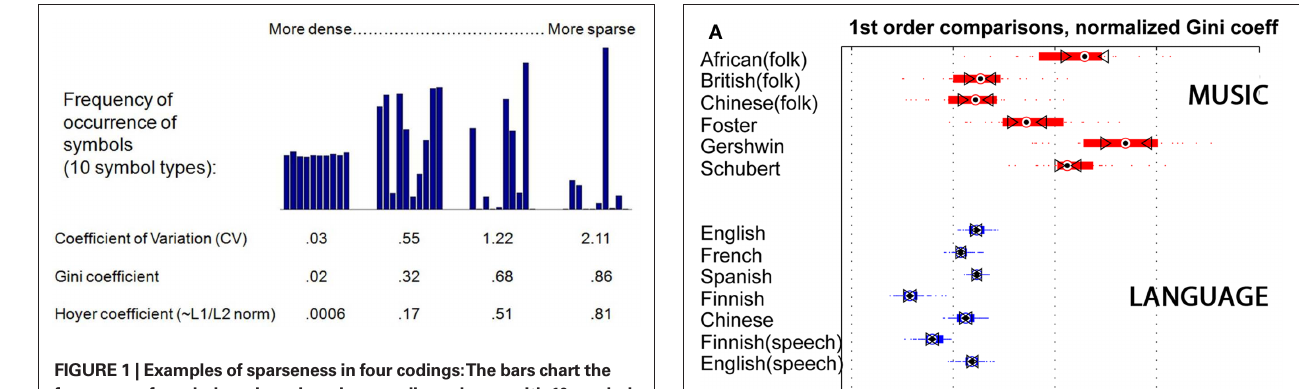
FIguRe 1 | examples of sparseness in four codings: The bars chart the frequency of symbol use in an imaginary coding scheme with 10 symbol types. In a dense coding scheme (left), the symbols are used with nearly equal frequency. In a sparse code, some symbols are used often, and others hardly at all.